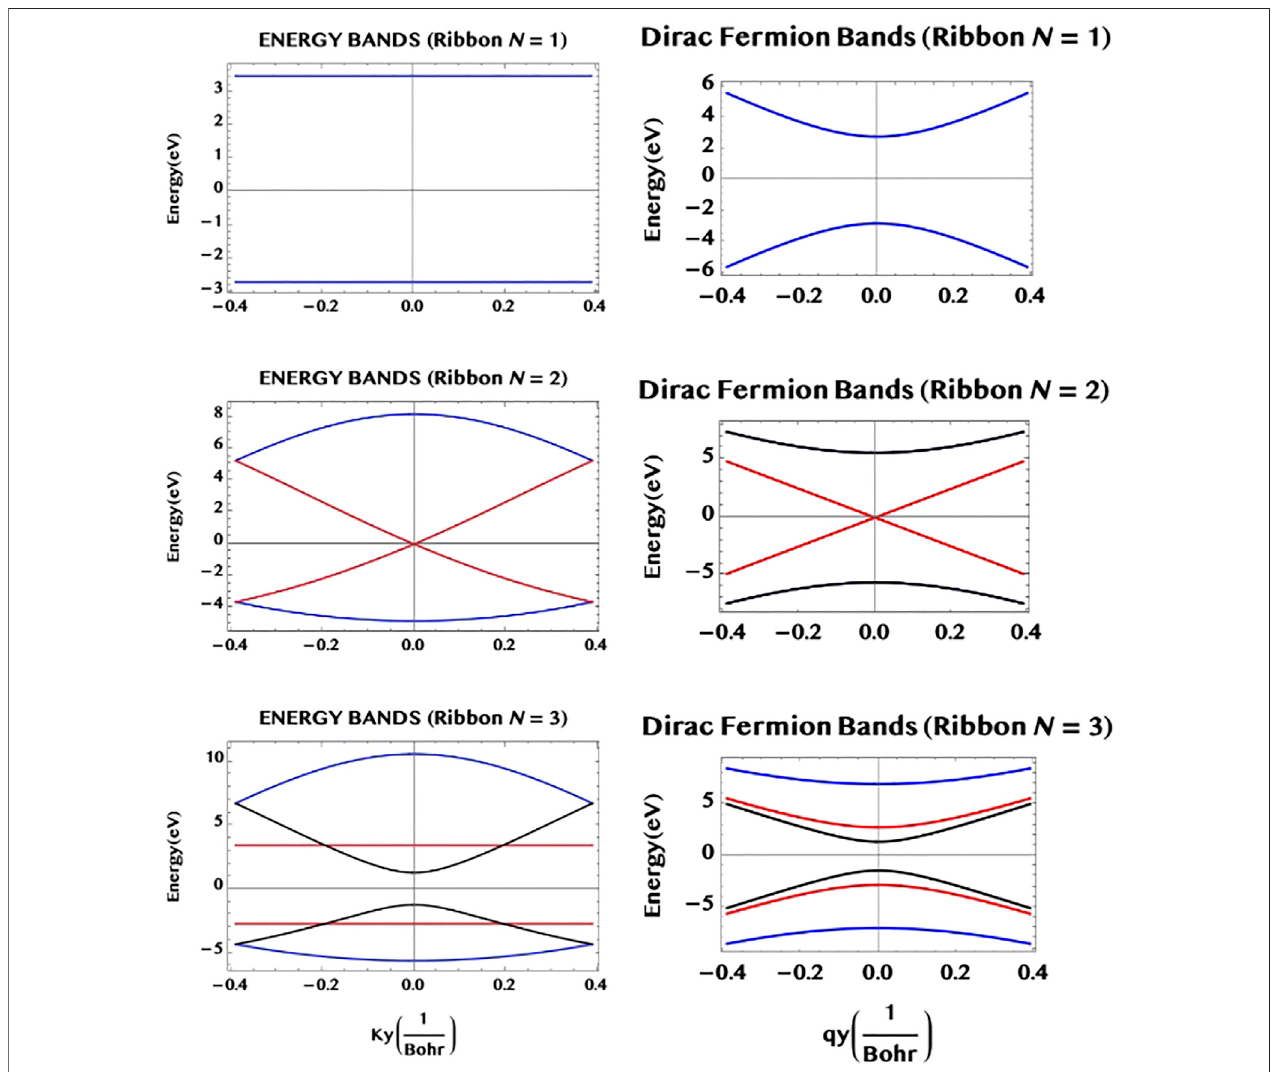
FIGURE 4 | The band structure of armchair graphene ribbons having widths N = 1, 2 and 3, are constructed using the two simple rules for the ribbons given in the text. The fullbands from the TB theory (left hand side column), as well as the approximate bands from the Dirac fermion model (righthand side column) are shown. They agreenearthemiddleofthebands(aDiracpoint)astheyshould(butdifferawayfromit).TheN=1ribbon( “ chain ” )hasasingle(r=1,blue)pairof “ fl at ” bandsofconstant separationalongthearmchair axis(horizontal y -axis);theN=2ribbonhastwopairsofVB-CBbands,onepair(r=2,red)isdegenerate attheDiracpoint;theN=3 ribbon hasthreepairs ofVB-CB bands,onepair(r=2,red)hasaconstantseparation(cf.N=1), whileanotherpair(r=3,black) showsa fi niteband-gapminimumat the centre as in a 1D semiconductor. Note that they follow the “ m-rules ” , for the occurrence of a degenerate and/or a “ fl at ” pair of sub-bands, as given in the text.